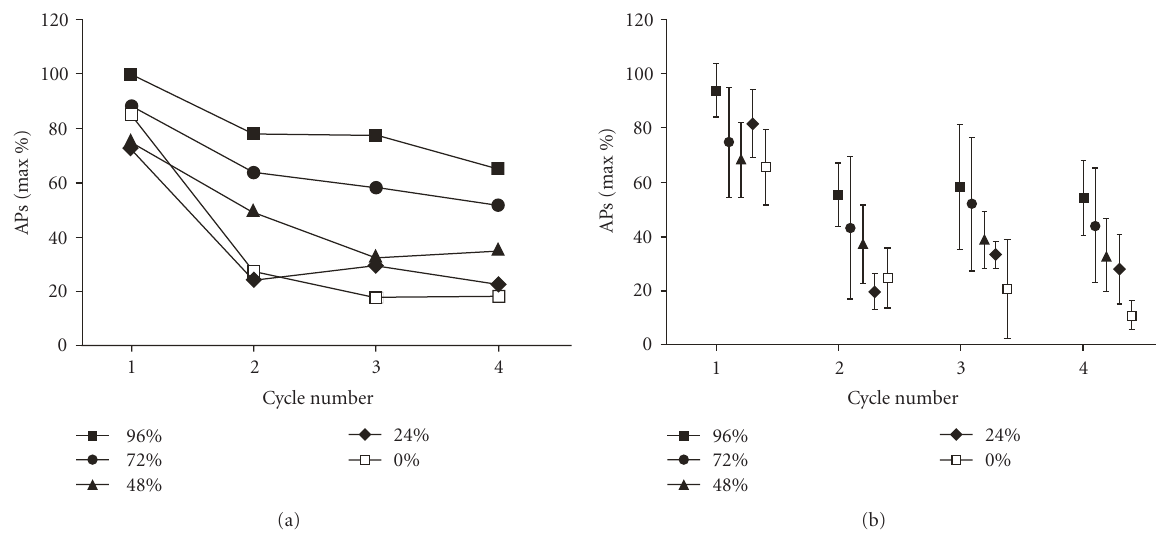
Figure 8: E ff ect of amplitude modulation depth on unit responses. (a) Normalized spike rate of a single unit is plotted as function of the number of AM cycles (AMF 4 Hz, CF 100 Hz) for di ff erent amplitude modulation depths (AMDs). (b) Normalized spike rates averaged across five MON units as function of the number of AM cycles (AMF 4Hz, CF 100 Hz) at di ff erent AMDs. Vertical bars represent one standard